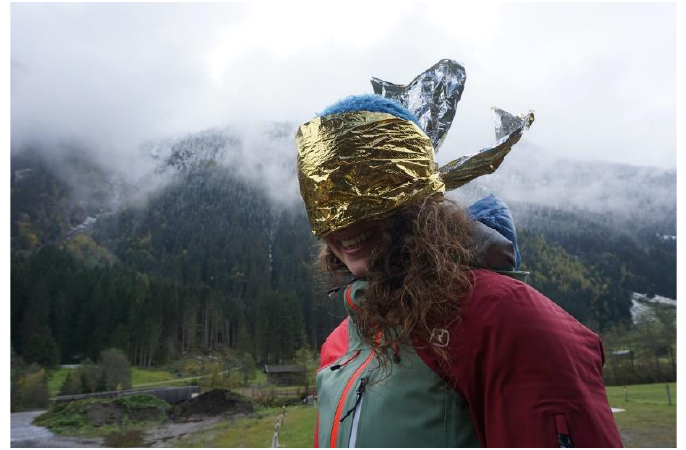
Figure 7. Application of a rescue blanket as emergency eye